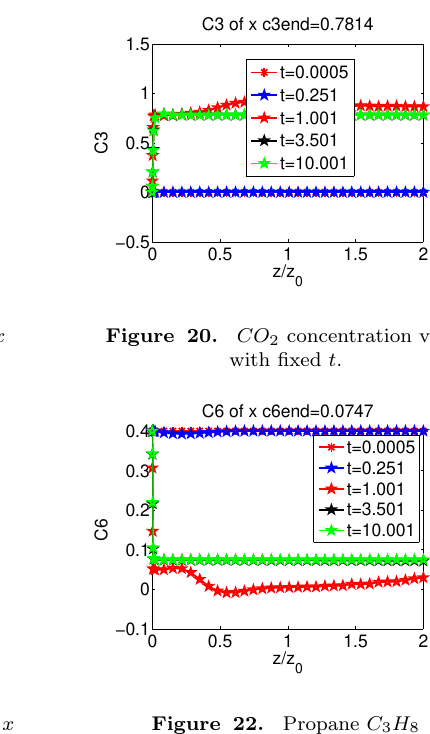
Figure 21. H 2 O concentration vs. x with fixed t .